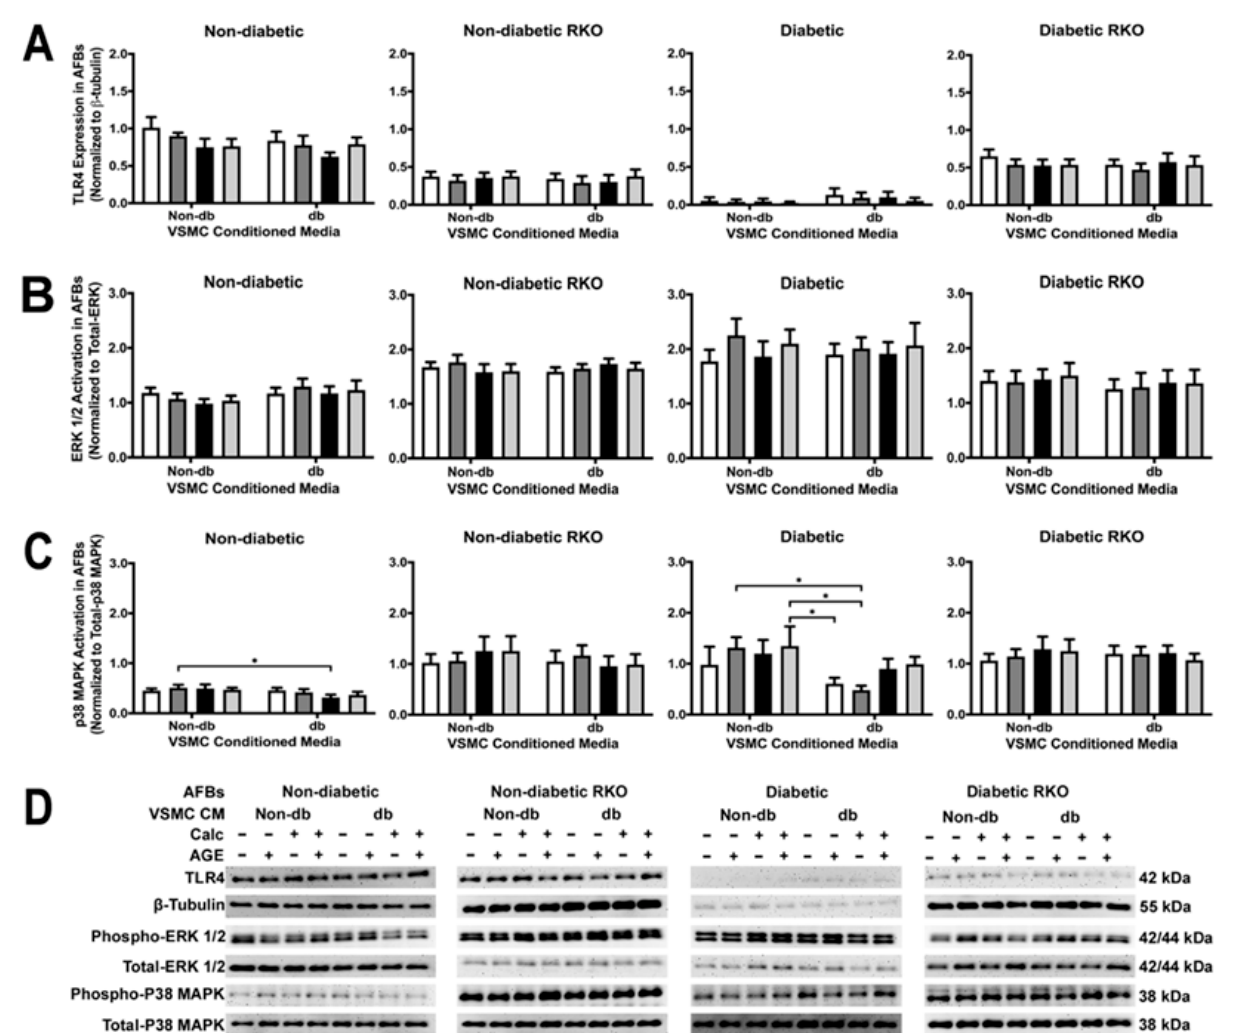
Figure 8. RAGE presence caused a decrease in p38 MAPK activation in AFBs due to diabetic- conditioned media while ERK activation TLR4 expression remained the same. Protein expression was quantified of TLR4 (95 kDa: ( A )), ERK 1/2 (42/44 kDa: ( B )) and p38 MAPK (38 kDa: ( C )). All protein levels were normalized to β -tubulin and ( D ) representative western blot images. Data was and graphed as mean ± SEM with n = 3–6 of independent replicates. A two-way ANOVA with Fisher’s LSD post hoc was performed (* p < 0.05) on each graph individually. All data were analyzed together with a two-way ANOVA to give the following: TLR4 (Interaction; p = 0.9501, Genotype; p < 0.0001, and Treatment; p = 0.5220), ERK 1/2 (Interaction; p = 0.9976, Genotype; p < 0.0001, and Treatment; p = 0.9408), and p38 MAPK (Interaction; p = 0.9292, Genotype; p < 0.0001, and Treatment; p =